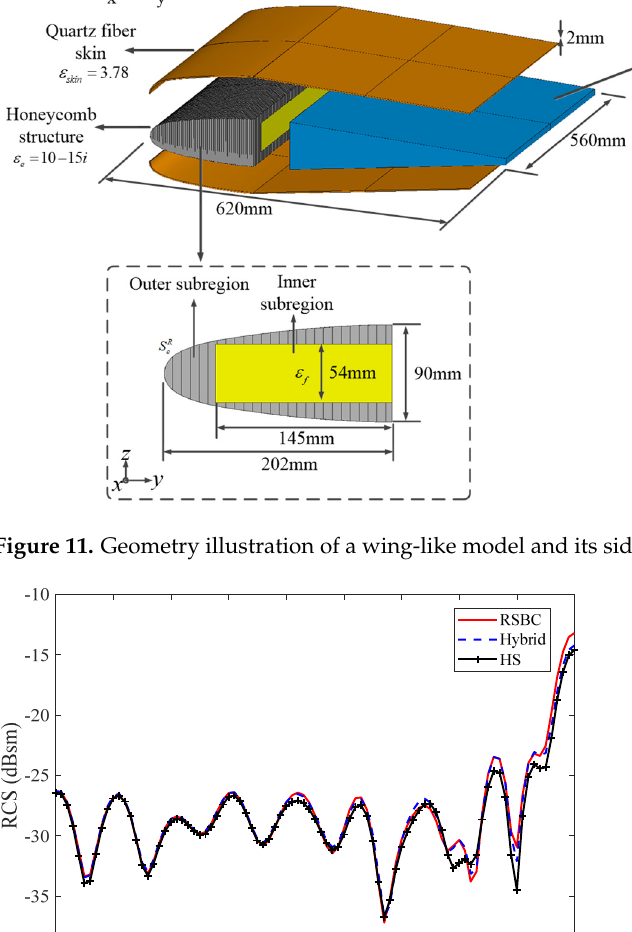
11 of 14 Figure 10. Comparison of VV-polarized monostatic RCS of sandwich structure at frequency of 8 GHz. The second example is a wing-like object. It has a length of 620 mm, a width of 560 mm, and a height of 90 mm. It consists of a quartz glass fiber skin with a relative permit- tivity of 3.78, a radar-absorbing honeycomb core, and a PEC frame. The upper and lower surfaces of the wing are covered with quartz glass fiber skins, as illustrated in Figure 11. We compute the bistatic RCS of the wing-like object at 4.5 GHz with the incident angle 0 0 0 ,